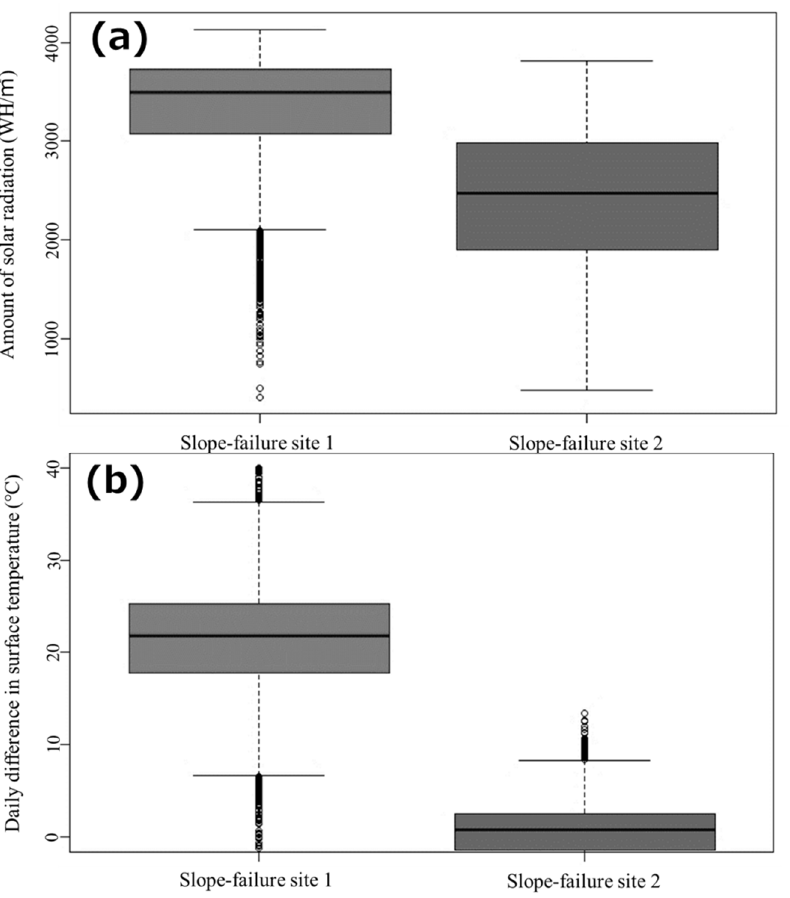
Figure 4. Comparison of the thermal environment of each site. ( a ) The annual amount of solar radiation created by DSM. ( b ) The daily range of ground-surface temperatures.